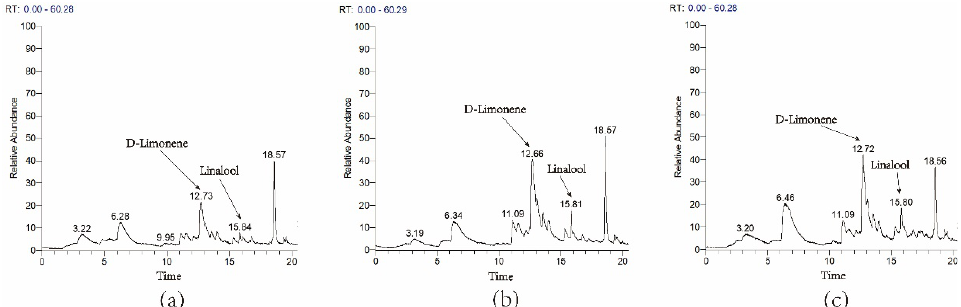
Figure 4. Transient overexpression of ZbDXS and ZbFPS in Nicotiana benthamiana . Control group ( a ). Transient expression of ZbDXS in Nicotiana benthamiana ( b ). Transient expression of ZbFPS in Nicotiana benthamiana ( c ) . The X − axis represents the retention time of the peak outflow, and the Y - axis represents the relative integrated area of the chromatographic peak.